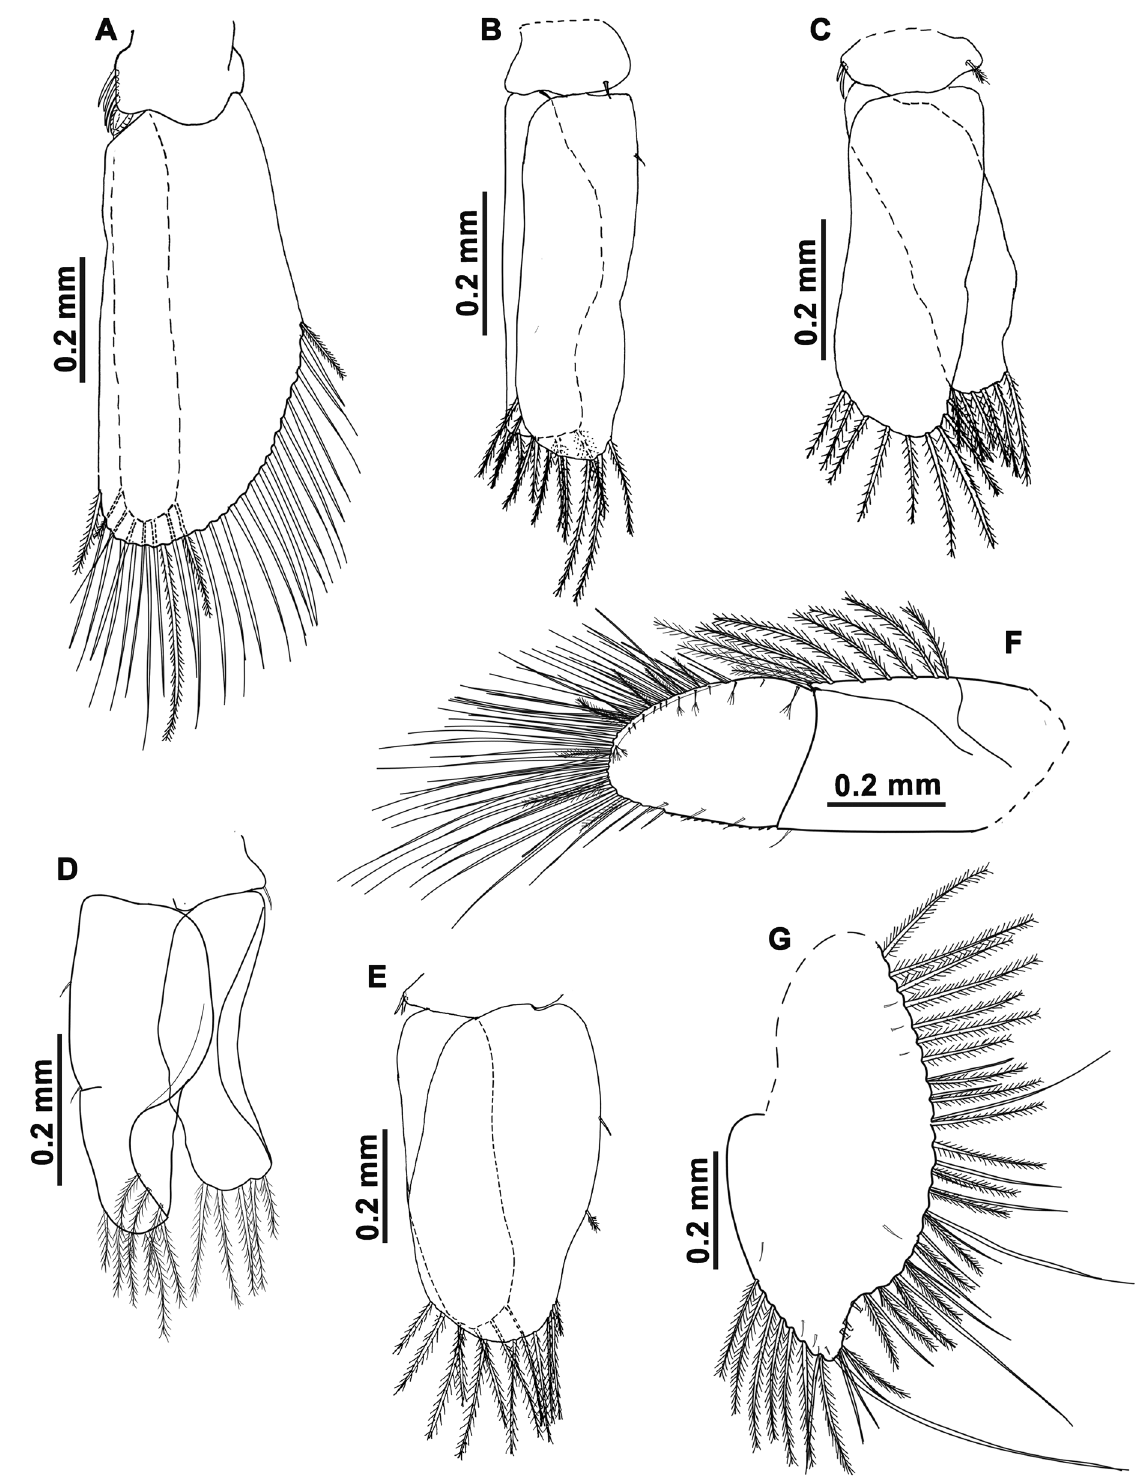
Fig. 13. Mesanthura estacahuitensis sp. nov., holotype, ♀, 6.8 mm, Oaxaca, Puerto Ángel, Estacahuite Beach (UMAR-PERA 547). A . Pleopod 1. B . Pleopod 2. C . Pleopod 3. D . Pleopod 4. E . Pleopod 5. F . Uropodal endopod. G . Uropodal